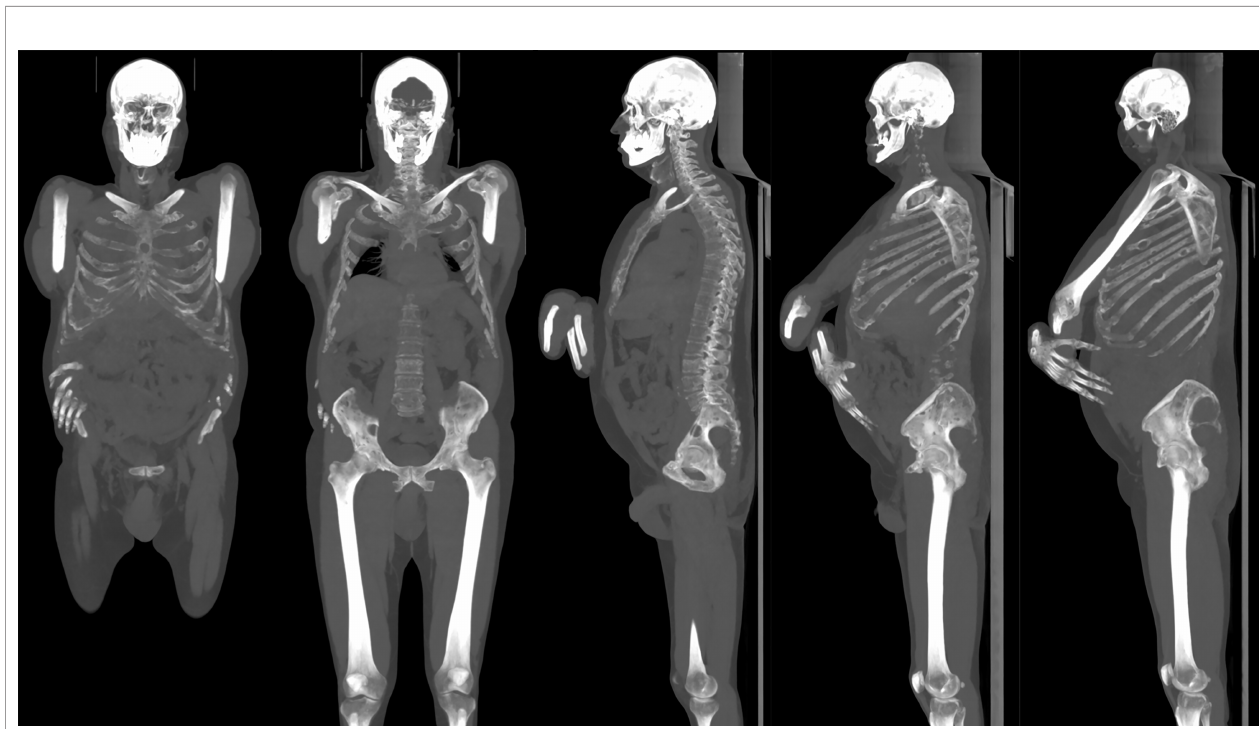
FIGURE 7 | Same patient in Figure 6 . Multiple osteolytic lesions can be appreciated on maximum intensity projection (MIP) reconstruction with thick slab (125